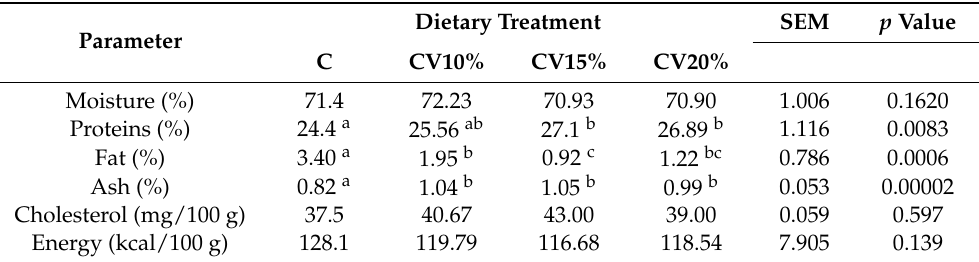
Table 4. Chemical composition and cholesterol in breast muscle of broilers chickens fed different levels of C. vulgaris for 40